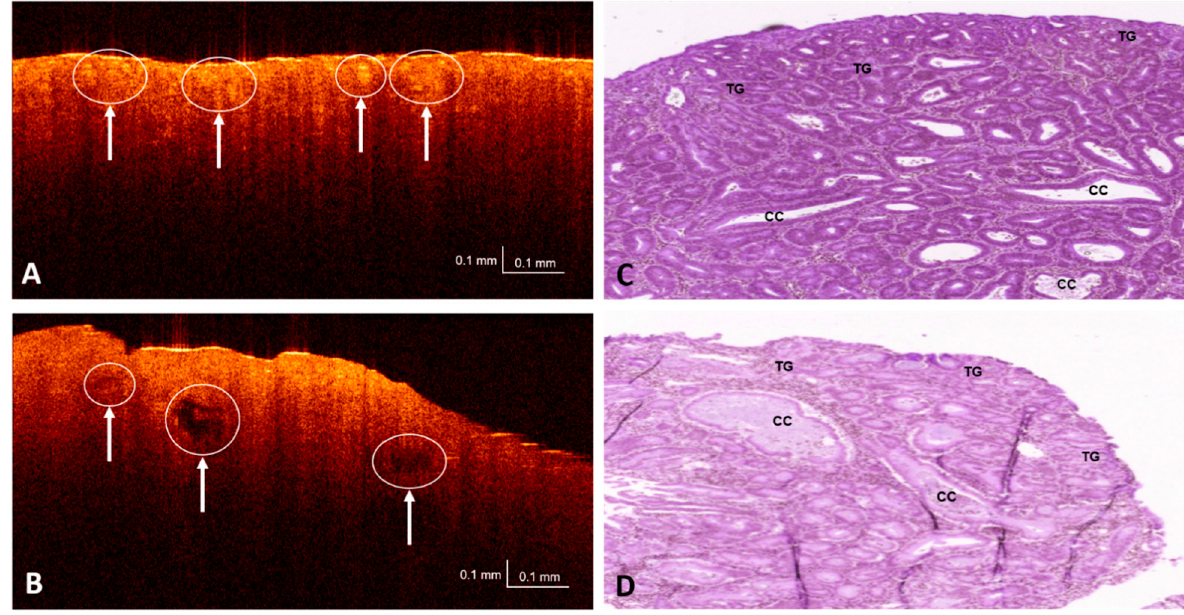
Figure 5. Comparison of features identified in OCT images ( A , B ) with respect to pathologists’ annotations on H&E images ( C , D ) on neoplastic samples (Figure 1B,C). CC: cystic crypt, TG: tumoral glands.